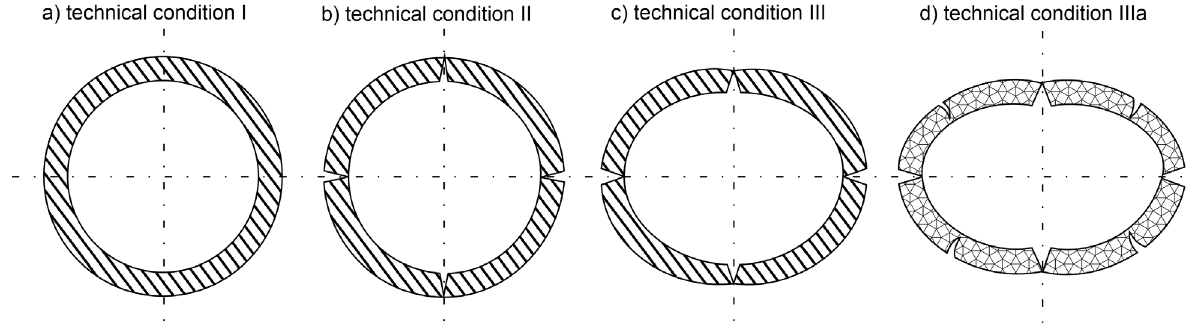
Figure 2: Technical conditions according to ATV 143-2; a) technical condition I; b) technical condition II; c) technical condition III; d) technical condition III a